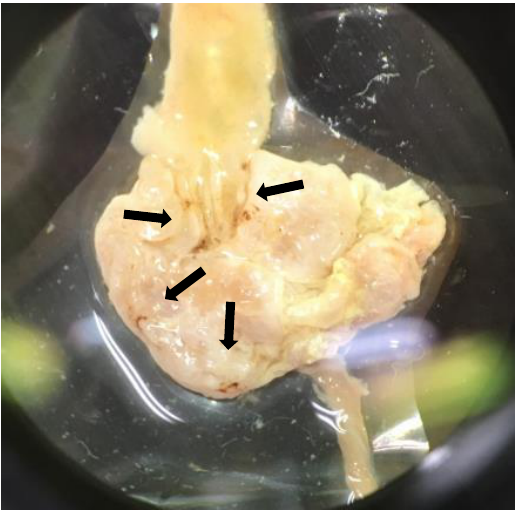
Figure 8. Areas of brown discoloration in the stomach of mouse. The arrows indicate areas of brown discoloration.